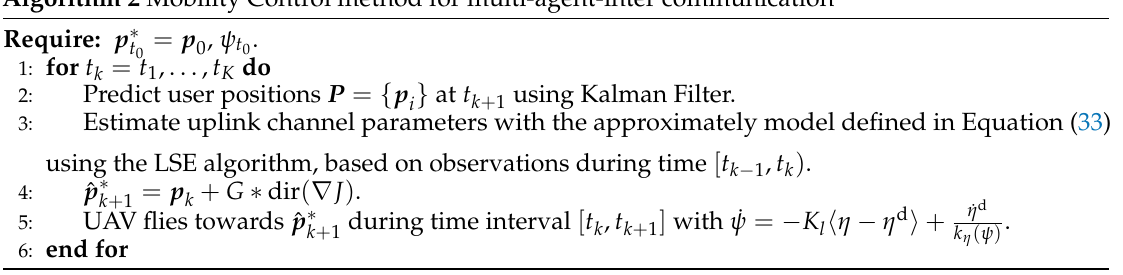
Algorithm 2 Mobility Control method for multi-agent-inter communication